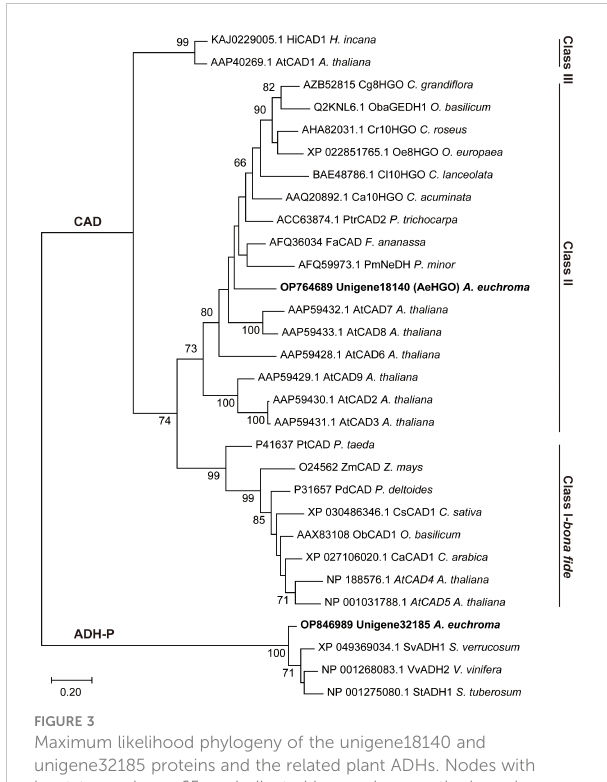
FIGURE 3 Maximum likelihood phylogeny of the unigene18140 and unigene32185 proteins and the related plant ADHs. Nodes with bootstrap values >65 are indicated by numbers on the